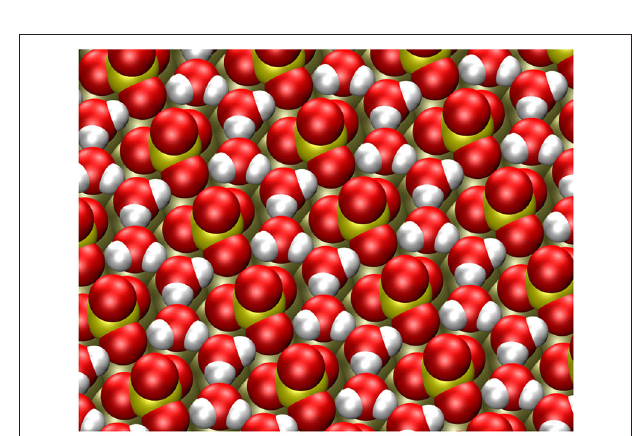
√ 7) R 19.1 ◦ sulfate structure ×